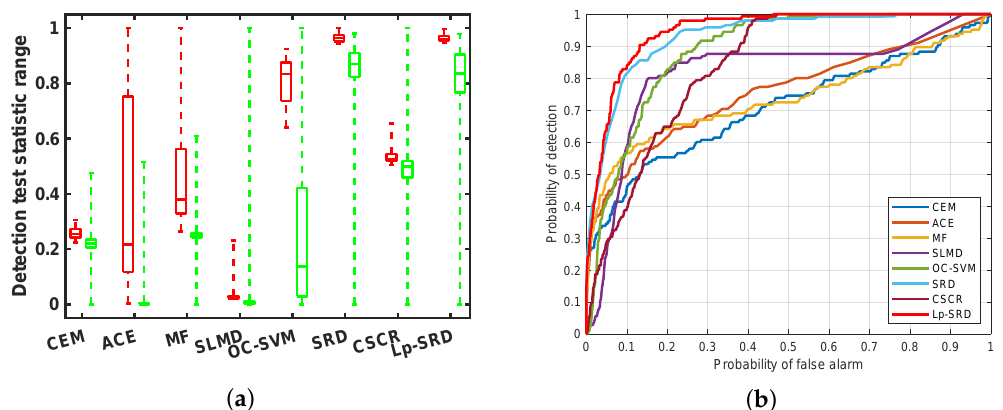
Figure 17. Detection performance using the HyMap dataset: ( a ) Statistical separability analysis. ( b ) ROC curves.